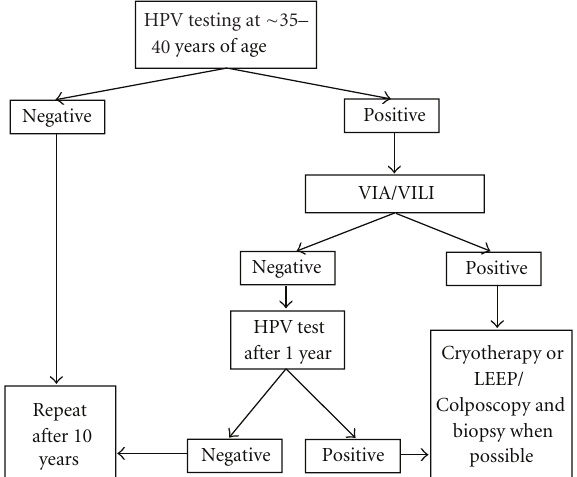
Figure 3: Schema for low-resource situations, starting with a ff ord- able HPV